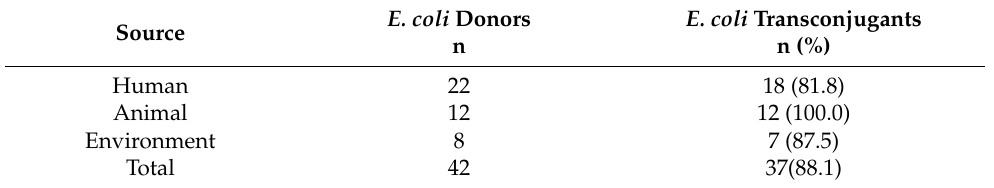
Table 5. Transfer success of bla CTX-M-15 among E. coli isolates of human, animals and the environment.